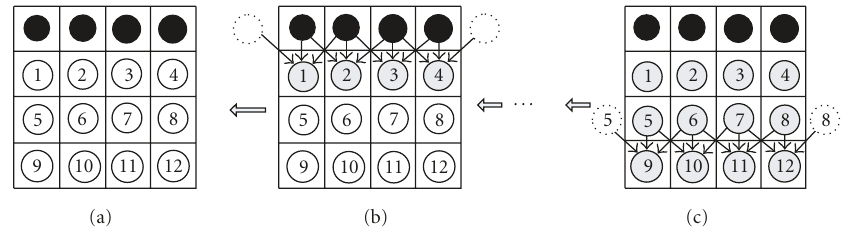
Figure 8: The reconstruction filtering operation.